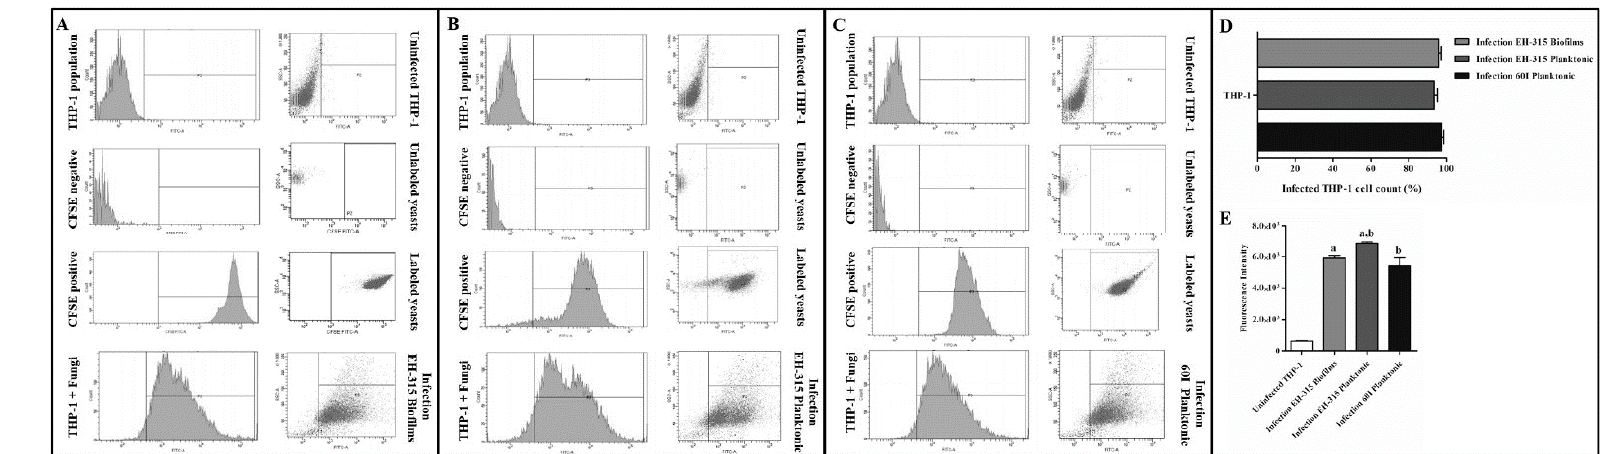
Figure 3. Analysis of THP-1 Mø-like cells- H. capsulatum yeasts interaction using flow cytometry. Flow cytometry profiles illustrating the fluorescence intensity (FI) of THP-1 Mø-like cells infected with ( A ) the EH-315 strain in biofilm cultures, ( B ) the EH-315 strain in planktonic cultures, and ( C ) the 60I strain in planktonic cultures 5 h after infection. Negative controls were uninfected cells (THP-1 cells population) and unlabeled yeasts (CFSE negative), while positive controls were fluorescently labeled yeasts (CFSE positive). THP-1 + Fungi represent the merged double population (THP-1 cells plus the fungal-stained CFSE). ( D ) Infection percentage and ( E ) FI (FITC-A mean) values demonstrate the interaction profile between THP-1 Mø-like cells and the EH-315 strain in biofilm and planktonic cultures or the 60I strain in planktonic cultures. The analyses were performed using a FACSCanto flow cytometer. The FI values were obtained from CFSE-labeled yeasts 5 h post-infection, by measuring 10,000 cells per tube, and they were analyzed using the FACSDiva software. Statistical data in graph E: (a) p < 0.01, THP-1 Mø-like cells infected with the EH-315 strain in planktonic cultures vs. THP-1 Mø-like cells infected with the EH-315 strain in biofilm cultures; (b) p < 0.0001, THP-1 Mø-like cells infected with the EH-315 strain in planktonic cultures vs. THP-1 Mø-like cells infected with the 60I strain in planktonic cultures.